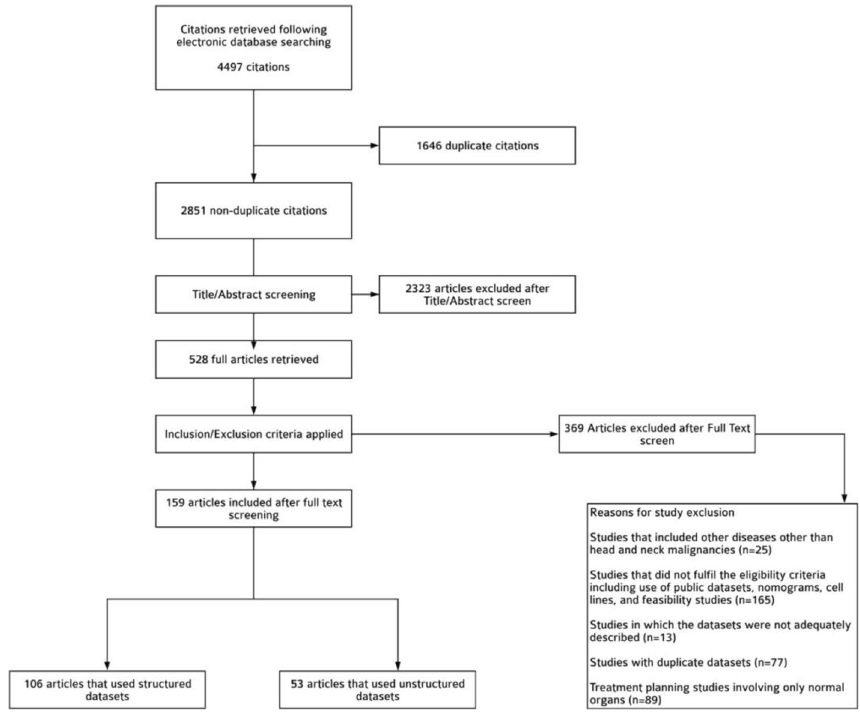
Fig. 1 Flowchart detailing the search strategy and article selection process in the